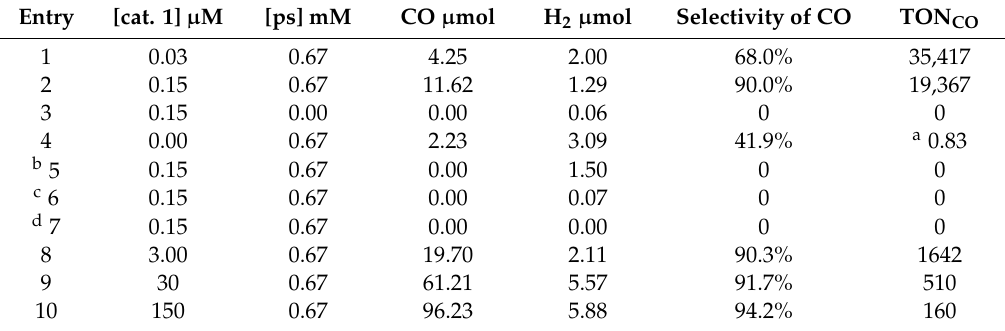
TEOA. Reaction conditions: LED light irradiation for 2 h, 4 mL CO 2 -saturated DMF/TEOA solution